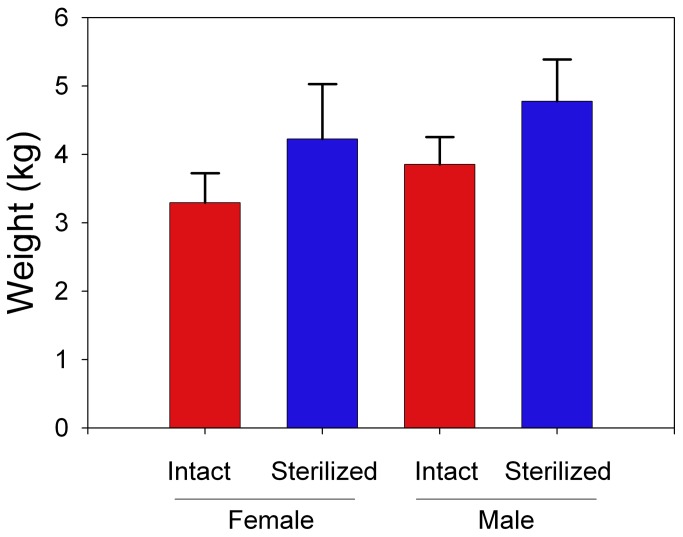
Mean (SE) body weights for free-ranging cats (n = 43) partitioned by reproductive status.All cats were sampled from the Chicago metropolitan area during 2008-2009. Reproductive status was defined as either intact or sterilized.